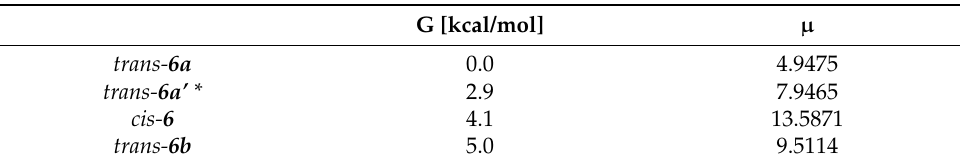
Figure 2. Conformational equilibrium for trans - 6 . To simplify the scheme, the pseudo axial and pseudo equatorial positions are shown as axial ( ax ) and equatorial ( eq ), respectively. Table 1. Relative energy differences in (kcal/mol) and the dipole moments (in D) for the studied conformers.